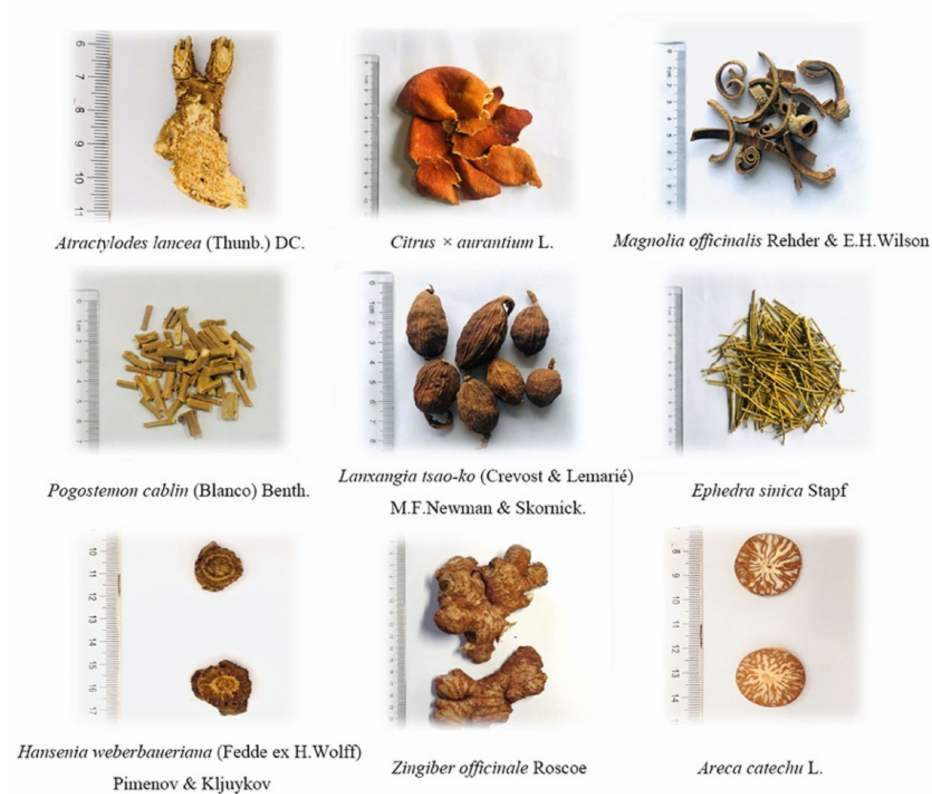
Figure 3. Some of the herbs used in Traditional Chinese Medicine. Reproduced under the terms of of Volatile Components From a Traditional Chinese Medicine Dayuan-Yin Against the COVID-19 Pandemic. Front Pharmacol 2020 , 11, 583651.